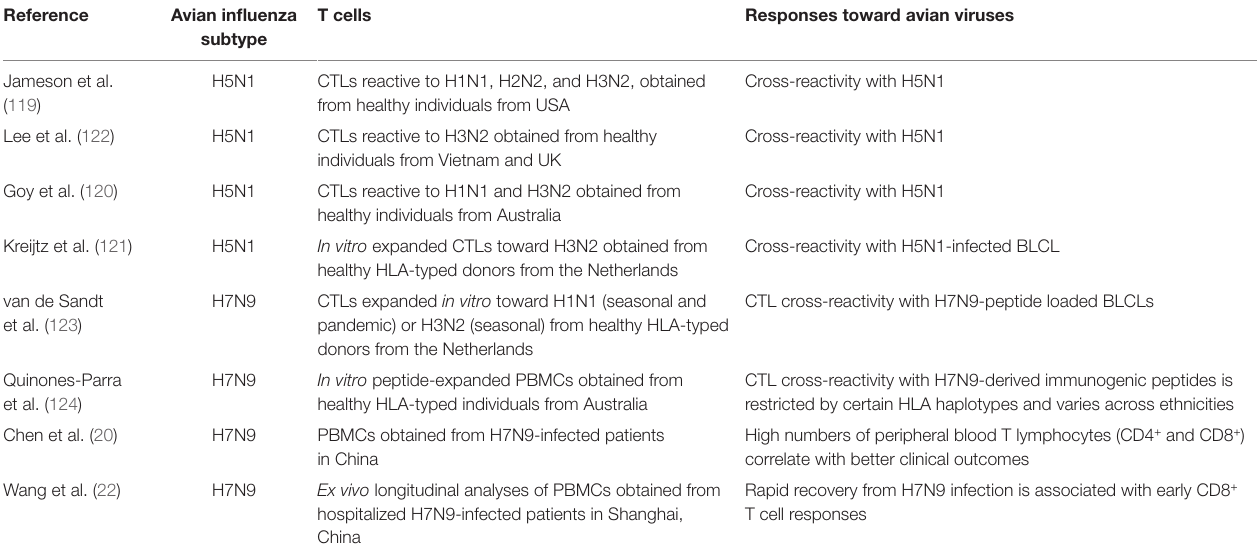
TABLe 2 | Relevant publications assessing human T cell immunity toward avian H5N1 and H7N9 influenza viruses.